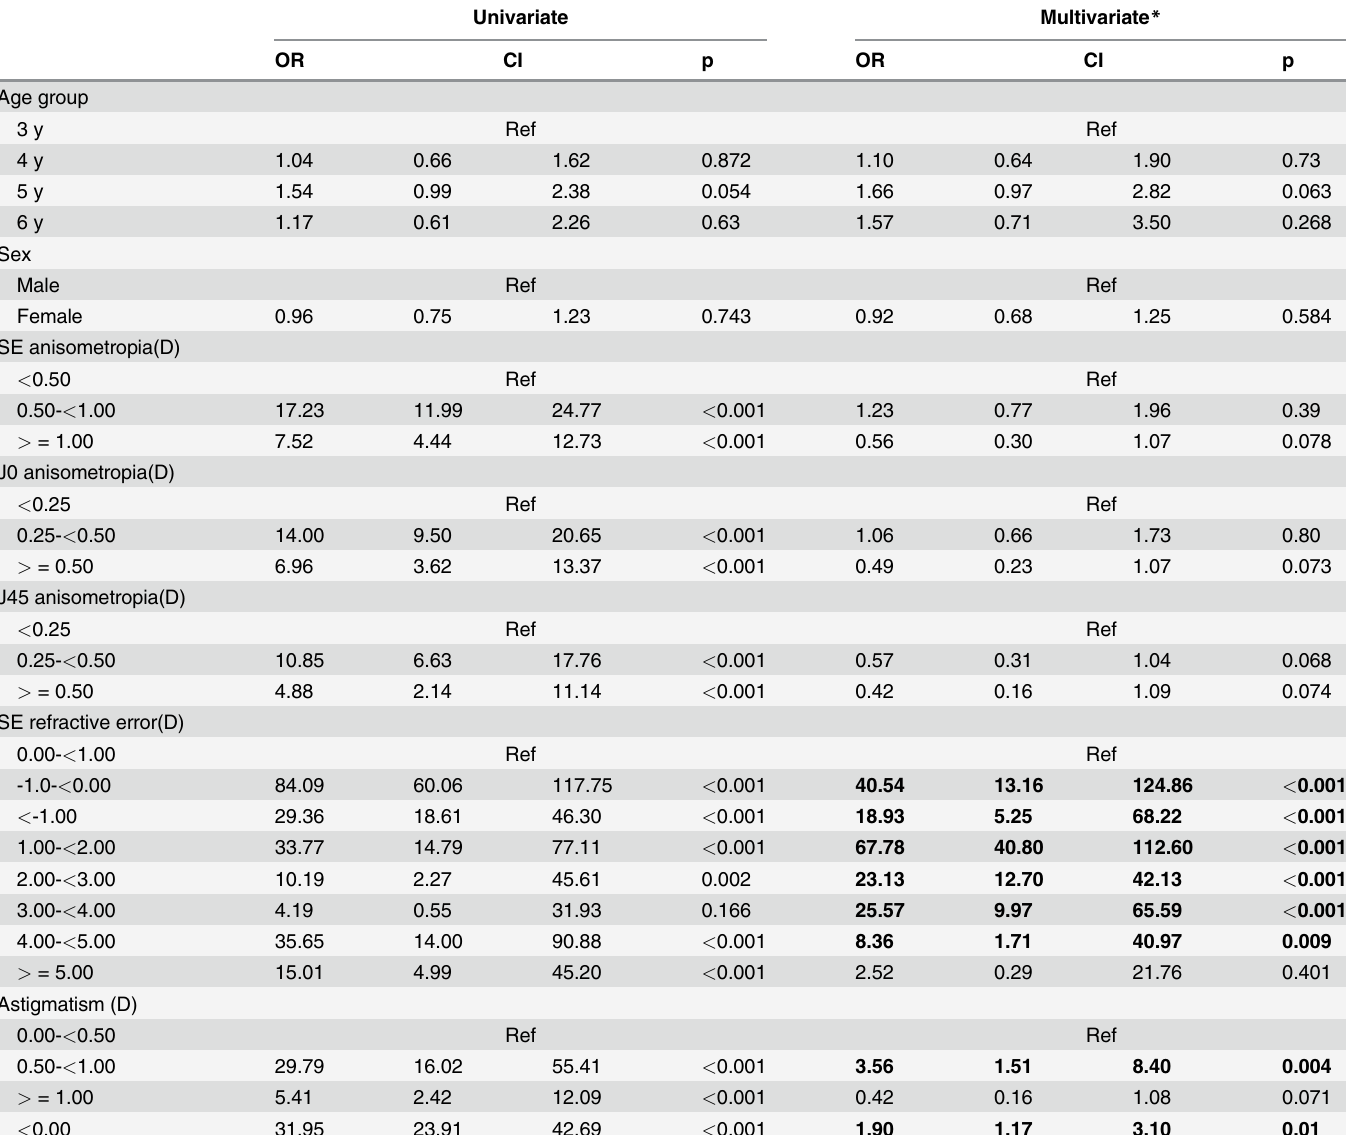
Table 3. Univariate and Multivariate Analyses for Associations between Refractive Error and Childhood Concomitant Exotropia. Univariate Multivariate